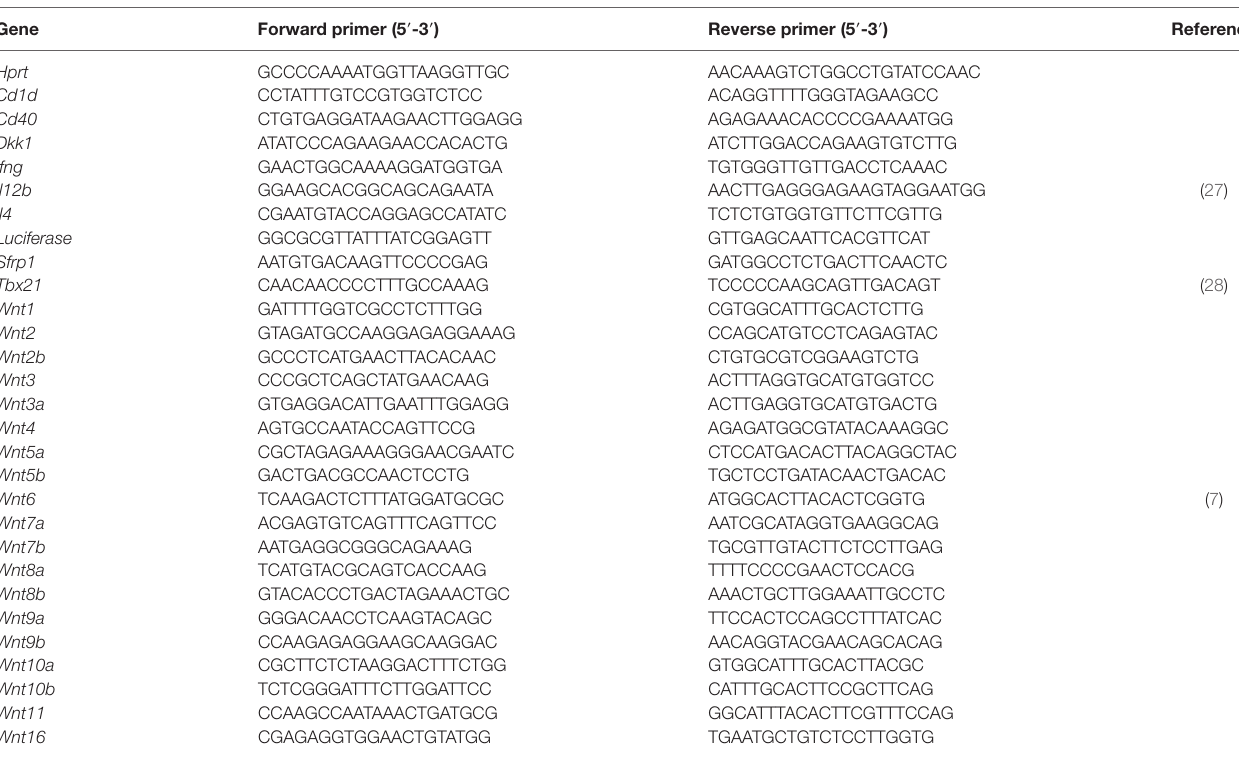
Table 1 | List of primers used in quantitative PCR. gene Forward primer (5 ′ -3 ′ ) reverse primer (5 ′ -3 ′